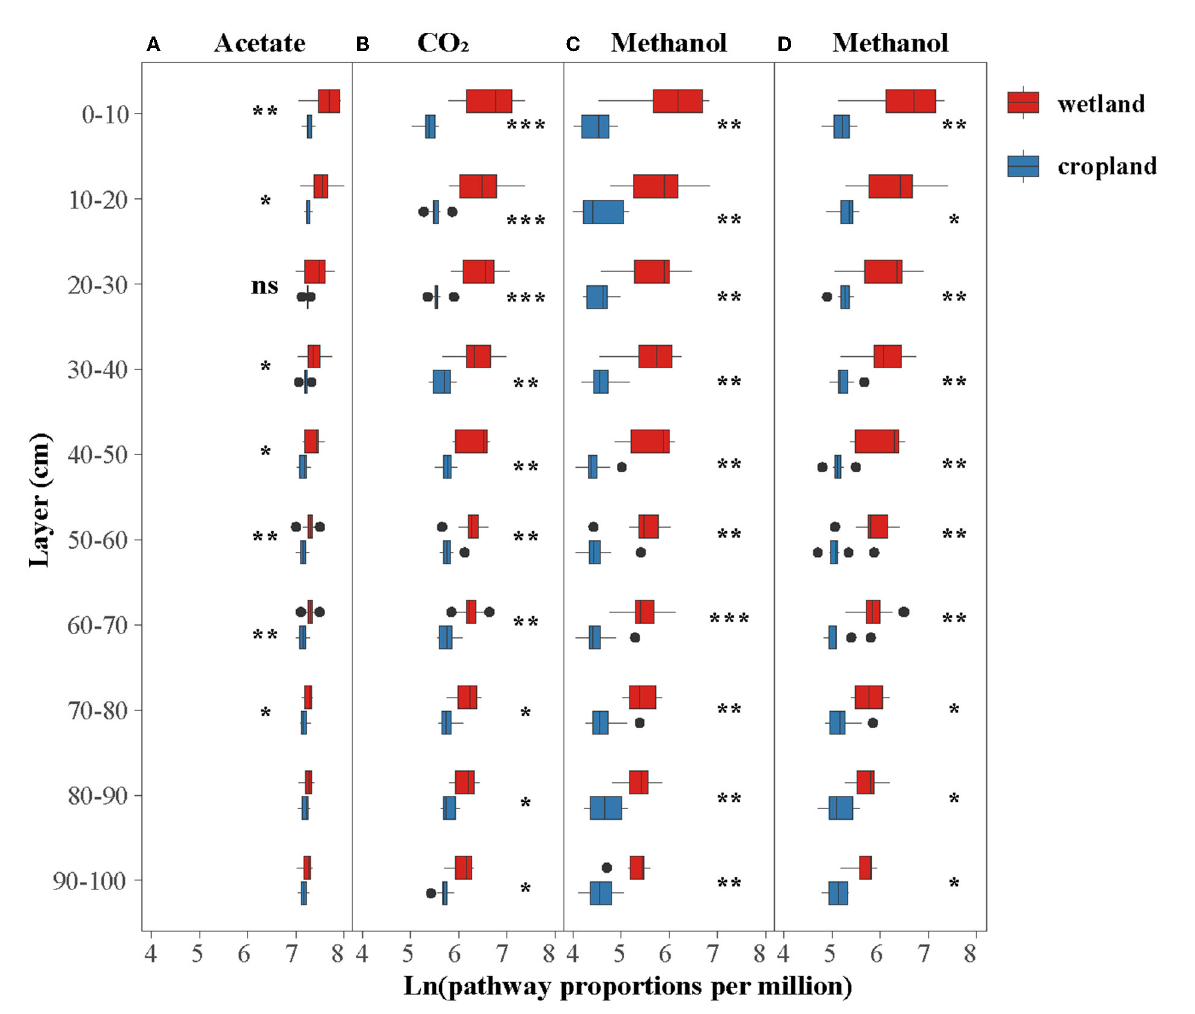
FIGURE3 Cultivation effects on the proportion of genes in four methane production pathways and layers. (A) Acetate pathway, (B) CO 2 pathway, (C) methanol pathway, and (D) methyl pathway. “*,” “**,” and “***” indicate a significantly difference between wetland and cropland (Kruskal–Wallis test, p < 0.05, p < 0.001, p < 0.0001,